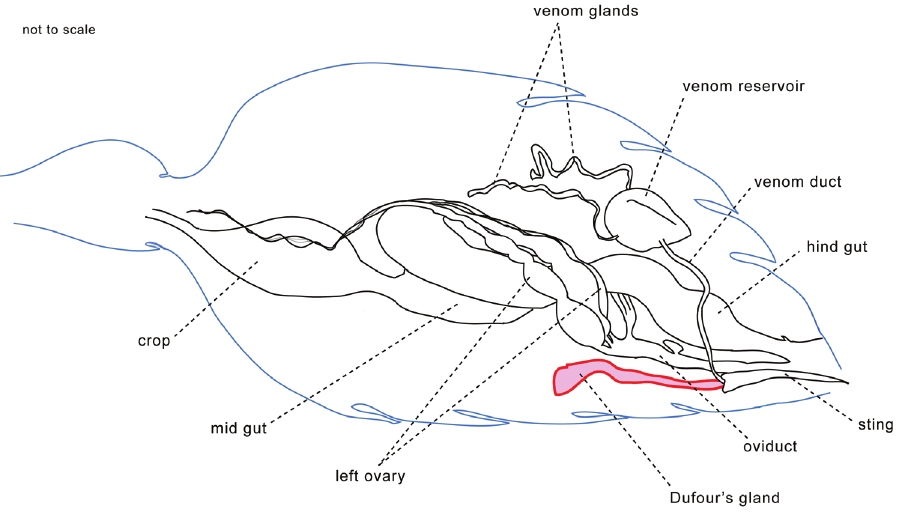
Figure 1. Diagram showing position of the Dufour’s gland among other abdominal organs in the polis- tine wasp Ropalidia marginata. (Drawing: author, not to